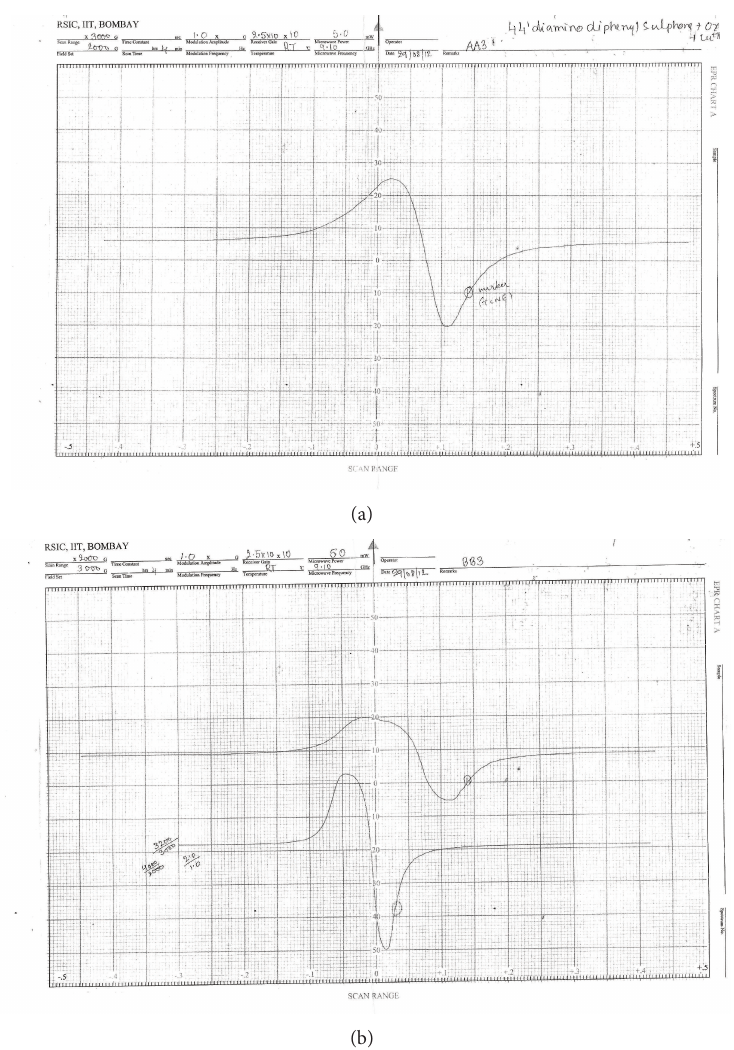
Figure 6: (a) ESR spectra of the [Cu 2 LCl 2 (H 2 O) 6 ] complex. (b) ESR spectra of the [Cu 2 L 󸀠 Cl 2 (H 2 O) 6 ] complex.